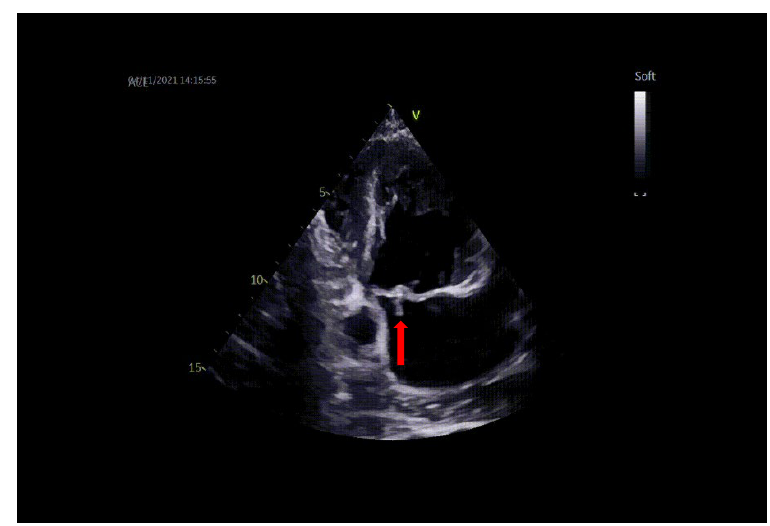
Figure 1. TTE: vegetation on the mitral valve prolapsing in LA (arrow) .